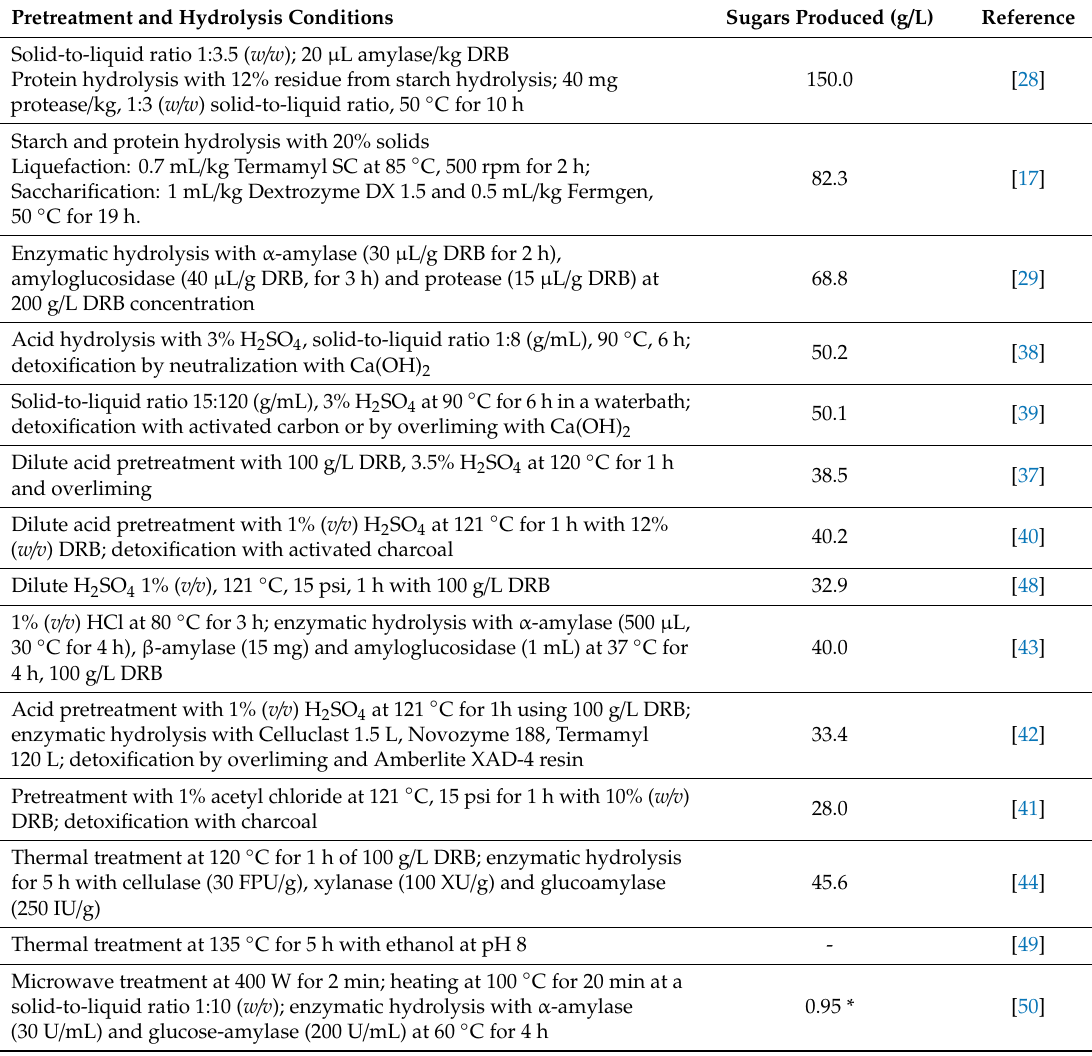
Table 2. Pretreatment methods and enzymatic hydrolysis conditions of